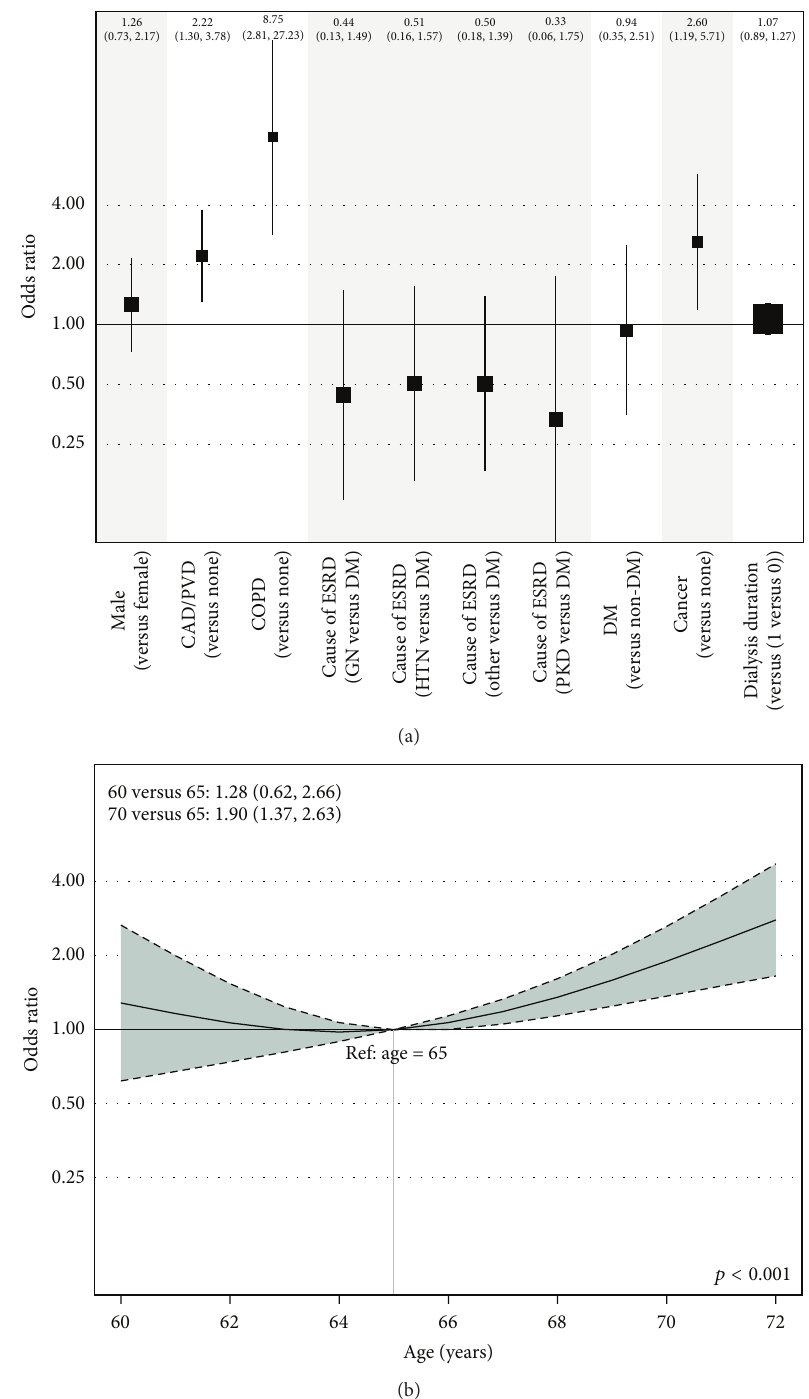
Figure 2: The logistic regression model estimates from the cohorts with 345 patients. (a) Selected clinical characteristics and the odds ratio for being turned down. (b) Patient age at time of referral and the odds ratio for being turned down.